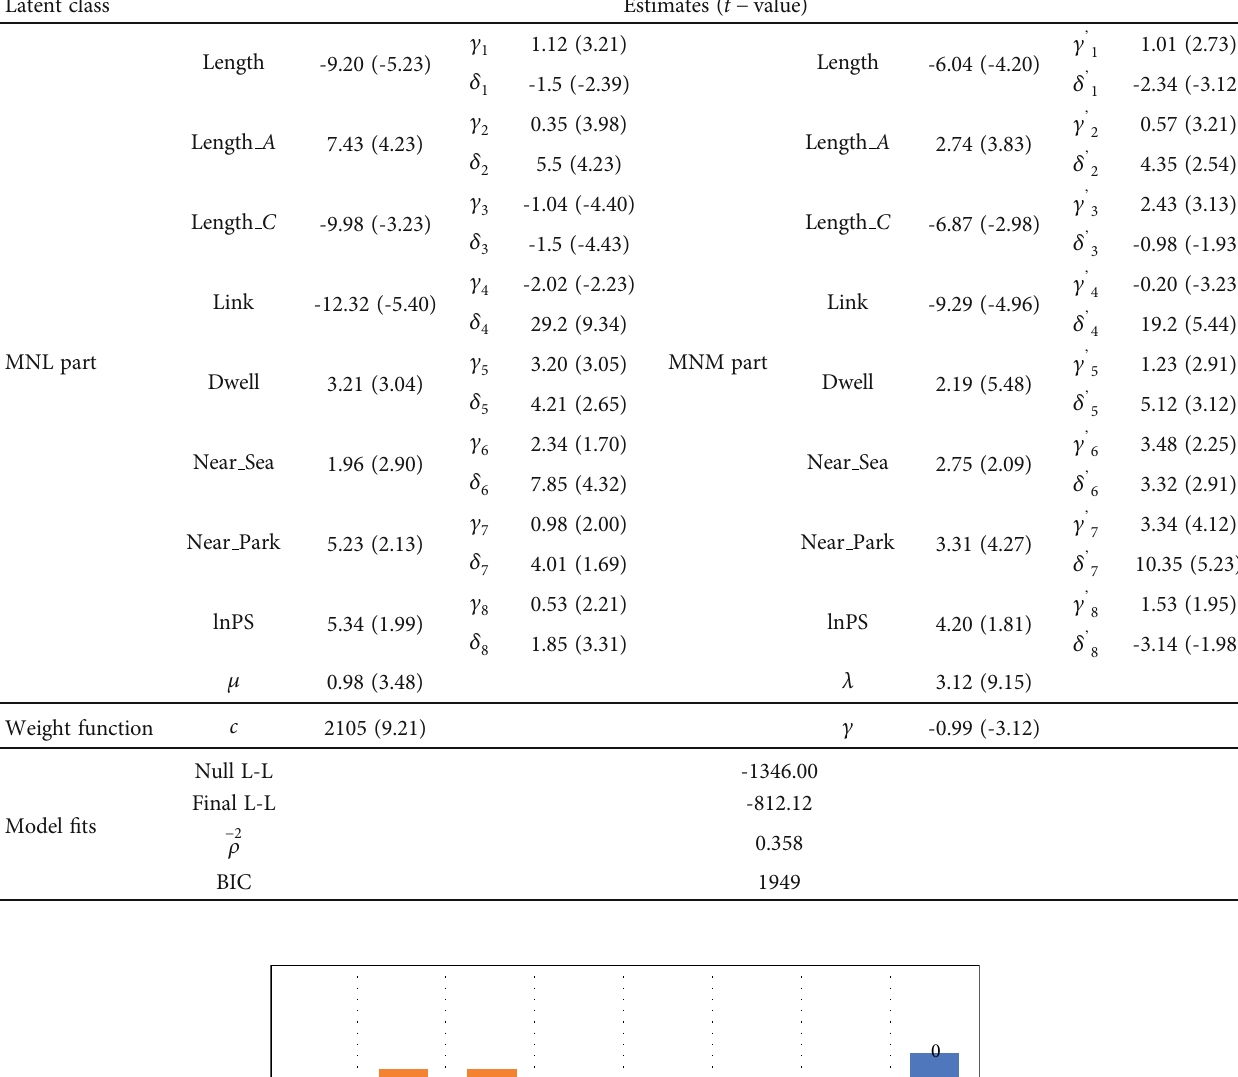
Table 5: Estimation results.